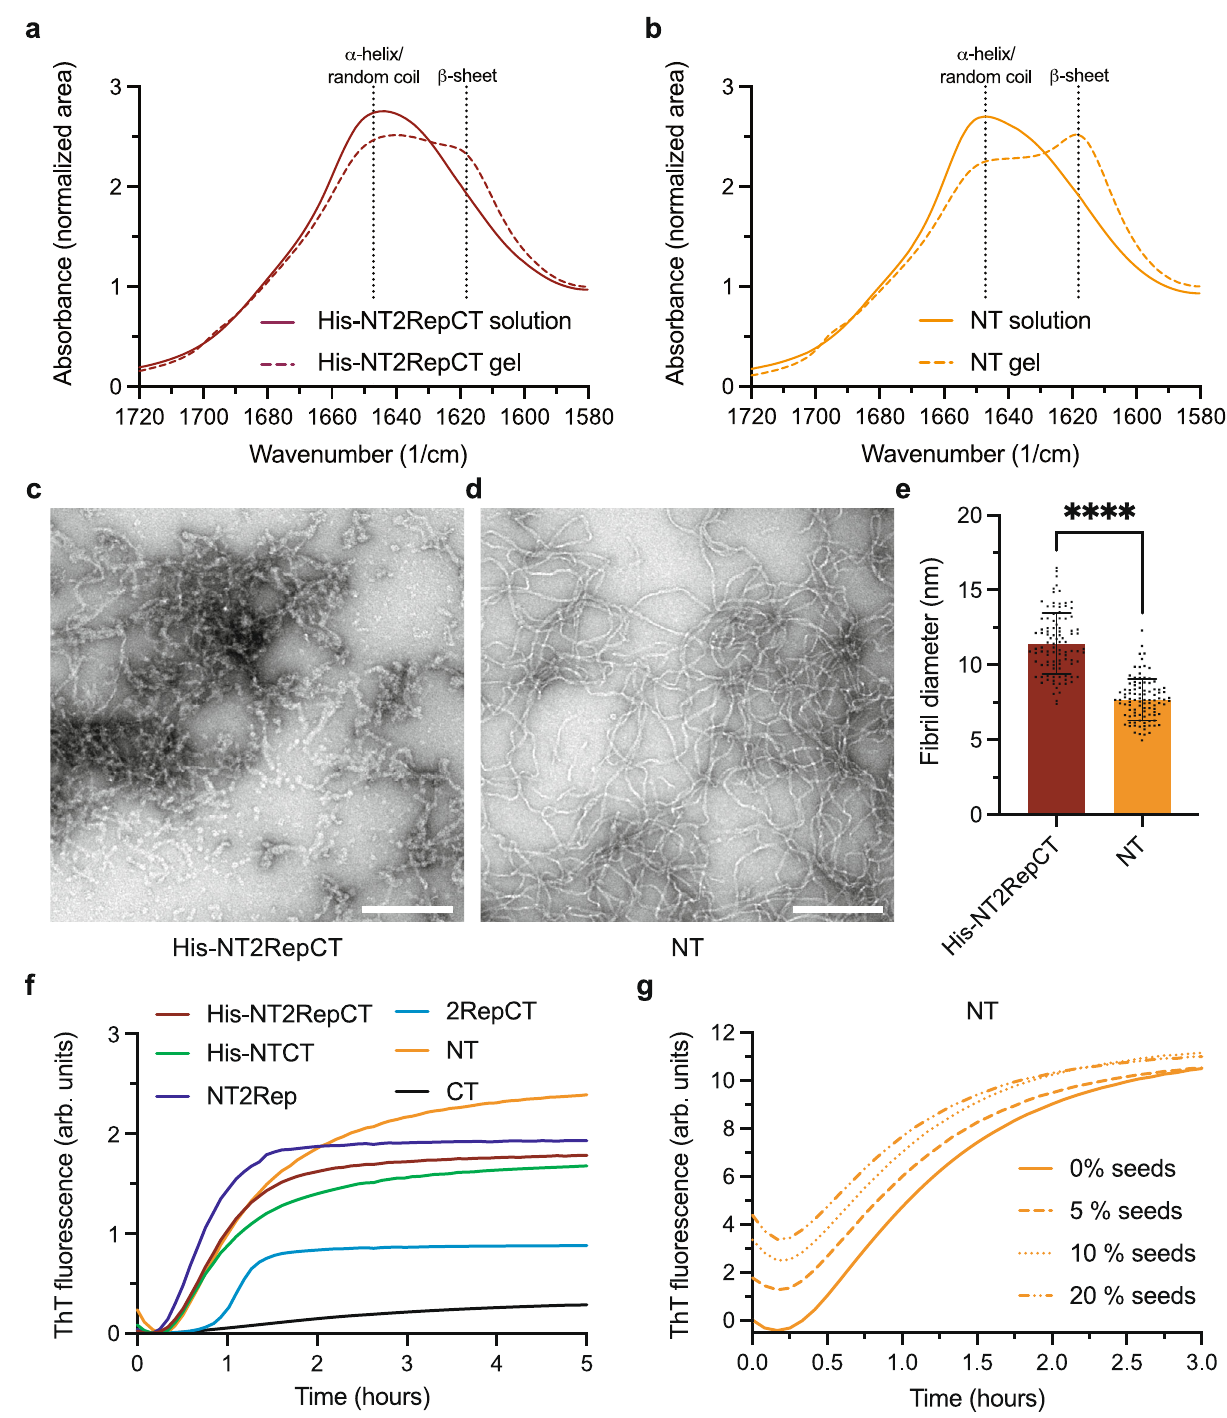
Fig.3|Structuralchangesduringhydrogelformation.a FTIRabsorptionspectra of His-NT2RepCT and b NT (both at 500mg/ml) before (solution) and after (gel) incubation at 37°C. c TEM image of a resuspended 50mg/ml NT2RepCT and d NT gel. Scale bars are 200nm. e Fibril diameters of His-NT2RepCT and NT hydrogels. n =100 fi brilsmeasured, p <0.0001. Errorbarsshowstandard deviation. Center of